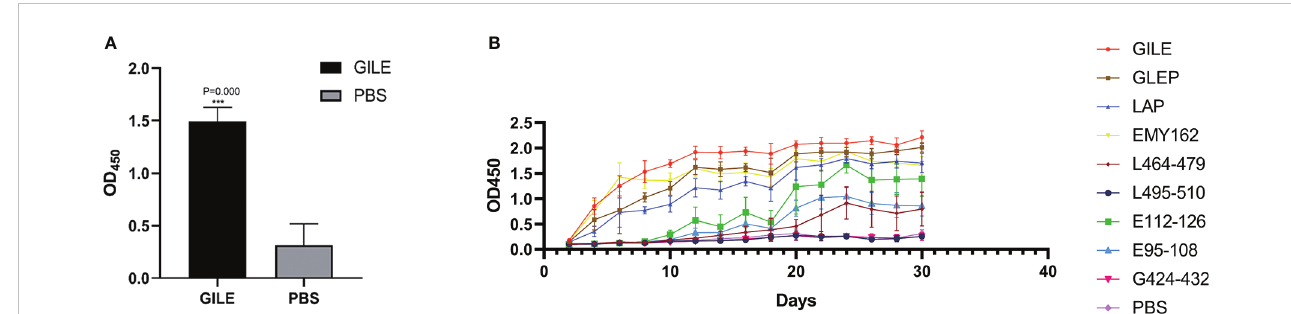
FIGURE 3 Detection of mice blood peripheral serum antibodies after inoculate vaccine by ELISA: (A) : The blood peripheral serum IgG levels of GILE and PBS groups after inoculate vaccine. (B) : Variation of blood peripheral serum IgG levels in 40 Days after inoculate vaccine.